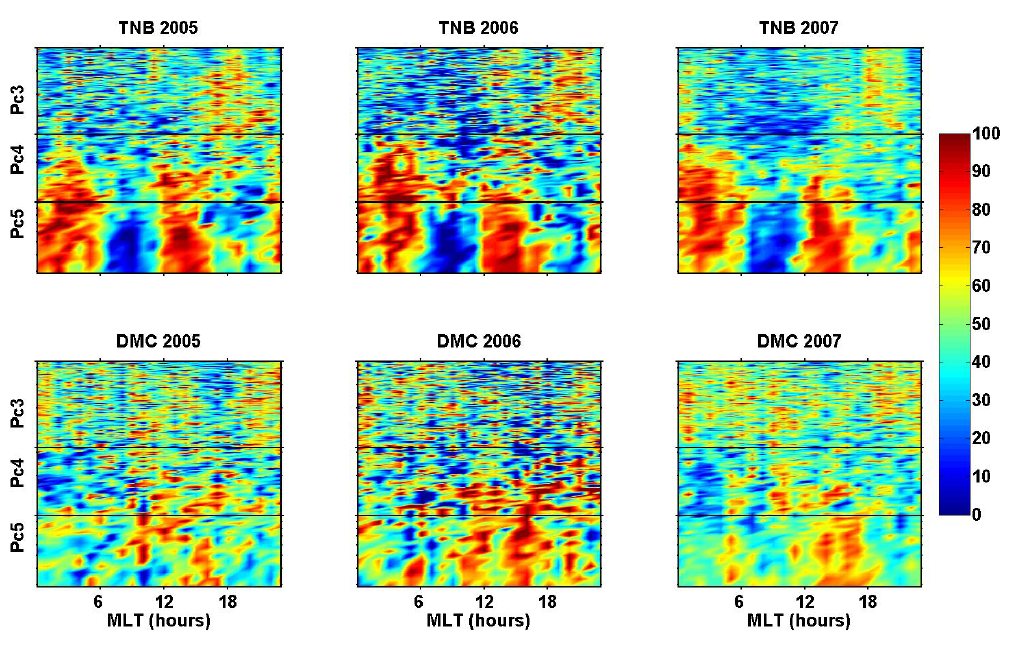
Fig. 7. MLT and frequency distribution of the percentage of CW events at DMC and TNB stations, separately for 2005, 2006 and 2007 summer months. Pc5, Pc4 and Pc3 labels indicate the band of frequency between the black horizontal lines on a log scale, i.e. 1–7 mHz, 7–22 mHz and 22–100 mHz,